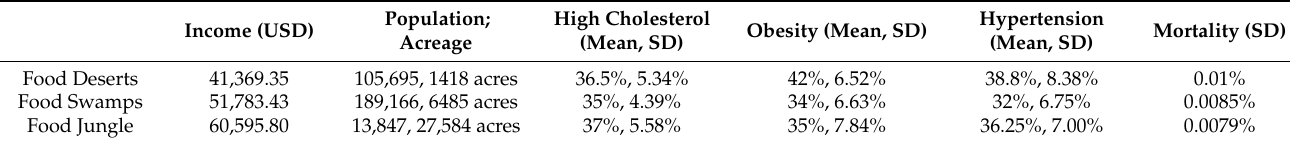
Table 2. The statistics (mean and standard deviation) of health issues, density, income, and mortality rates in each food access